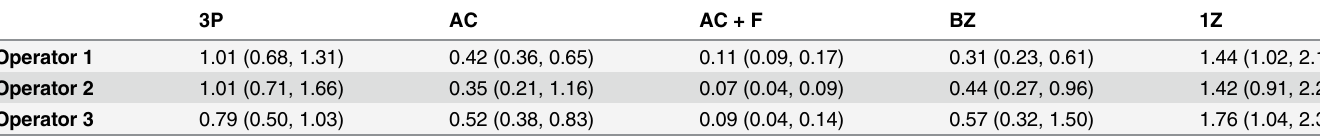
Table 2. Accuracy values of each superimposition technique.